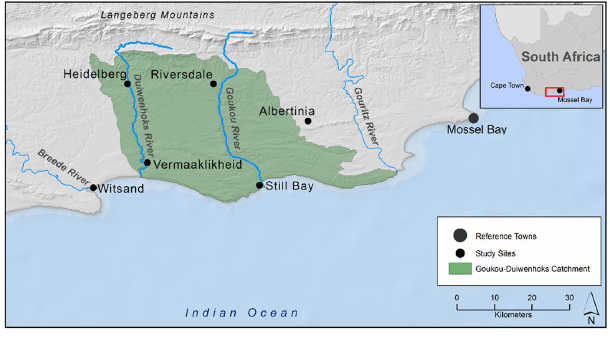
Fig. 1 . Location of the research area at the local scale of South Africa’s southern Cape and Agulhas Bank, highlighting prominent towns and features mentioned in the